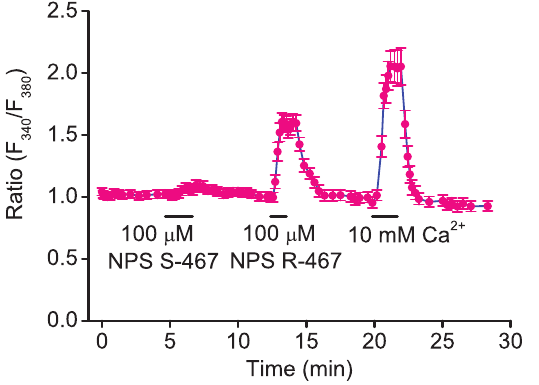
Figure 1. Intracellular Ca 2 + -imaging in isolated frog parathy- roid cells. Extracellular application of 100 m M NPS R-467 and 10 mM Ca 2 + induced large responses in 26 cells, but 100 m M NPS S-467 is less effective than R-467.